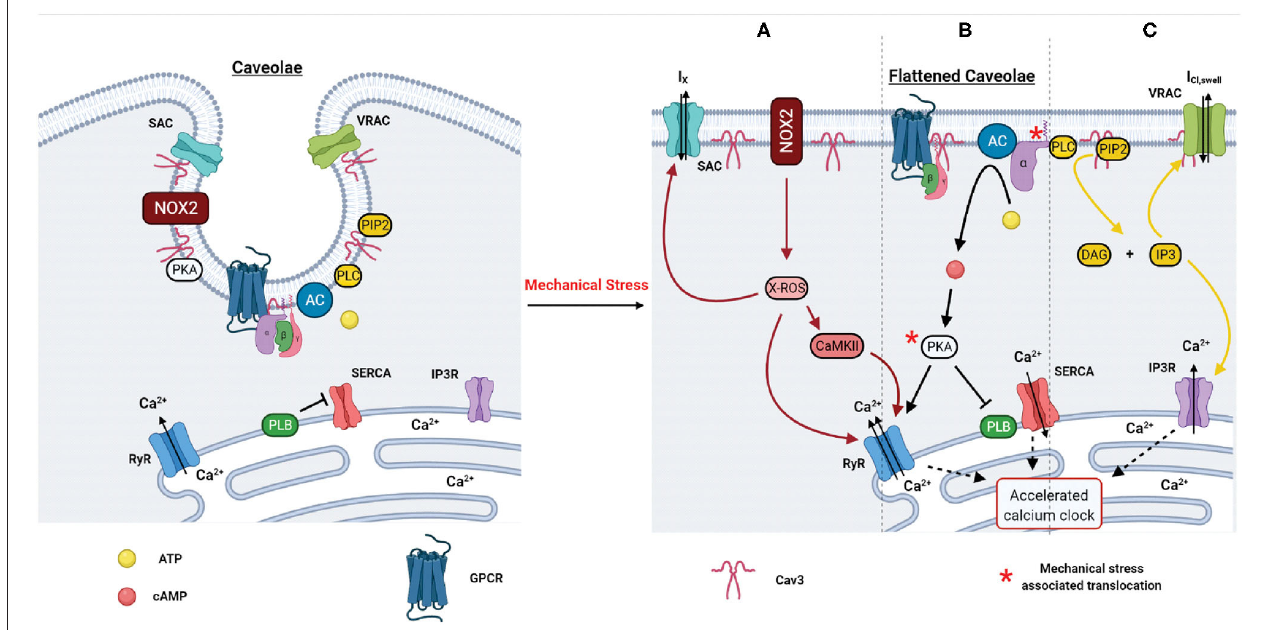
FIGURE 4 | Proposed effect of mechanical loading on caveolae-associated signaling pathways and their effect on sinoatrial node calcium clock function. Mechanical stress: (A) Activates X-ROS signaling via NOX2 (NAPDH oxidase 2) which stimulates CaMKII activity and upregulates RyR (ryanodine receptor) function leading to an accelerated calcium clock, as well as sensitizes SAC (stretch-activated channels) for increased activation. (B) Displaces the GPCR alpha subunit, activating AC (adenylyl cyclase)-mediated conversion of ATP to cAMP, which activates PKA leading to an accelerated calcium clock via RyR activation and PLB (phospholamban) inhibition of SERCA (sarcoplasmic reticulum Ca 2 + -ATPase). (C) Induces PLC (phospholipase C)-mediated conversion of PIP2 to IP 3 (inositol triphosphate), which activates IP 3 receptors (IP 3 R) and an accelerated calcium clock and also activates VRACs (volume regulated anion channels). All three pathways lead to accelerated cardiomyocyte calcium cycling, LCR (local calcium releases) rate, and increased activity of mechanosensitive